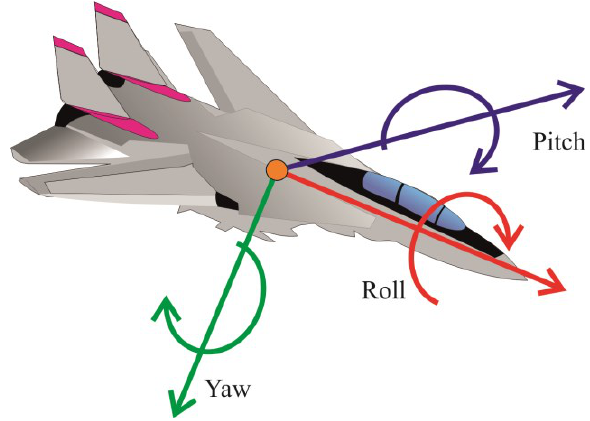
Fig. 3. An illustration of RPY